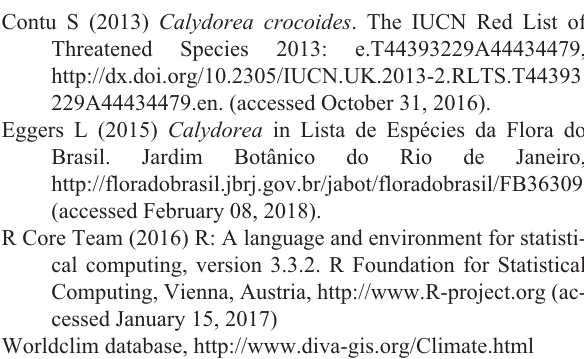
Table S1 - Collection sites of Calydorea crocoides and conservations units. Table S2 - Pairwise Nei’s genetic identity for Calydorea crocoides